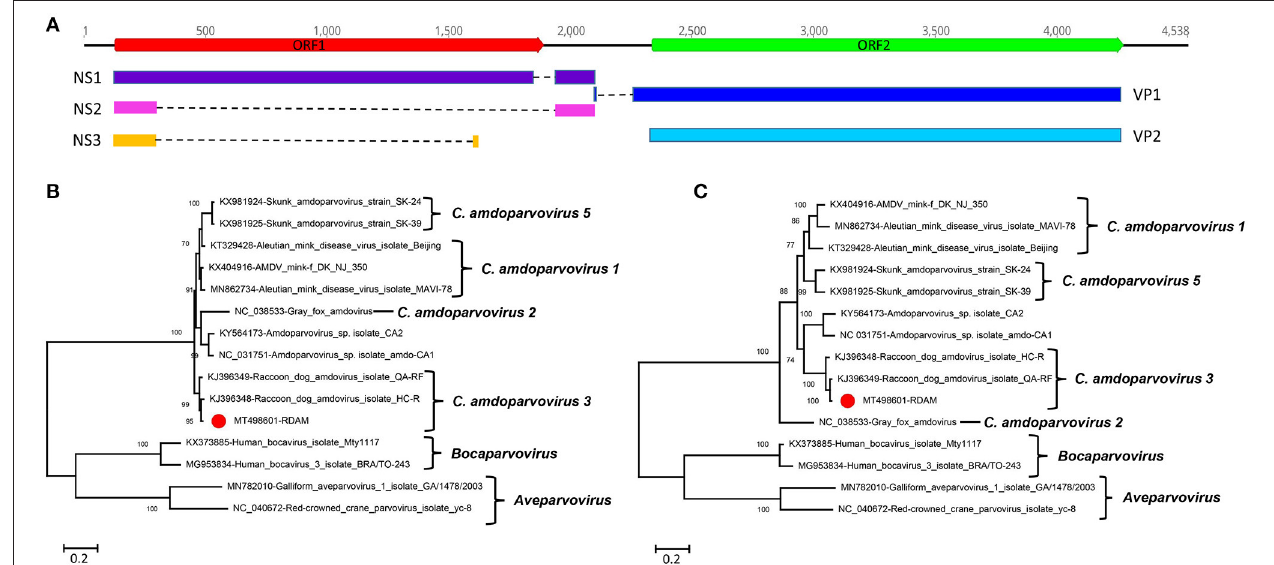
FIGURE 2 | Genomic organization and phylogenetic analysis of the amdoparvovirus identified in raccoon dogs. (A) Genomic organization of RDAM. The open reading frames and viral encoding proteins of RDAM were marked with different colors. (B) Phylogenetic analysis based on the amino acid sequences of NS1 of RDAM and reference strains of the genus Canine amdoparvovirus , Bocaparvovirus , and Aveparvovirus in the family Parvoviridae . (C) Phylogenetic analysis based on the amino acid sequences of VP2 of RDAM and reference strains of the genus Canine amdoparvovirus , Bocaparvovirus , and Aveparvovirus in the family Parvoviridae . The RDAM identified in this study was marked with a red solid